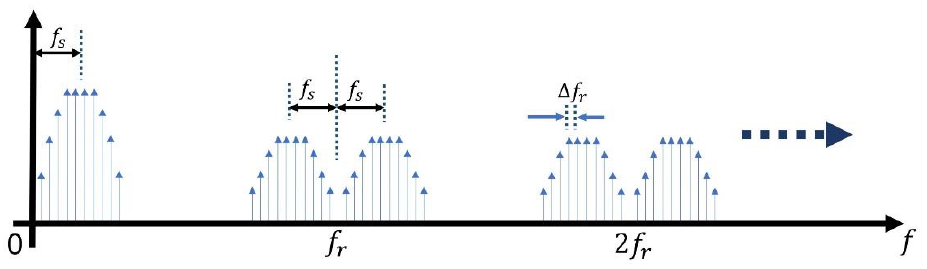
Figure 8. A radiography of the electrical spectrum after the dual comb is mixed. 𝑓 𝑠 is the frequency shift applied in the FS stage, which is 1 MHz. ∆𝑓 𝑟 is the repetition frequency difference between the two RF signals applied on the comb generation stage (the two EOPM after the FS). In this case, ∆𝑓 𝑟 = 10 kHz . 𝑓 𝑟 is the repetition frequency of the RF signals applied in the comb generation stage. In this case, 𝑓 𝑟 = 500 MHz .